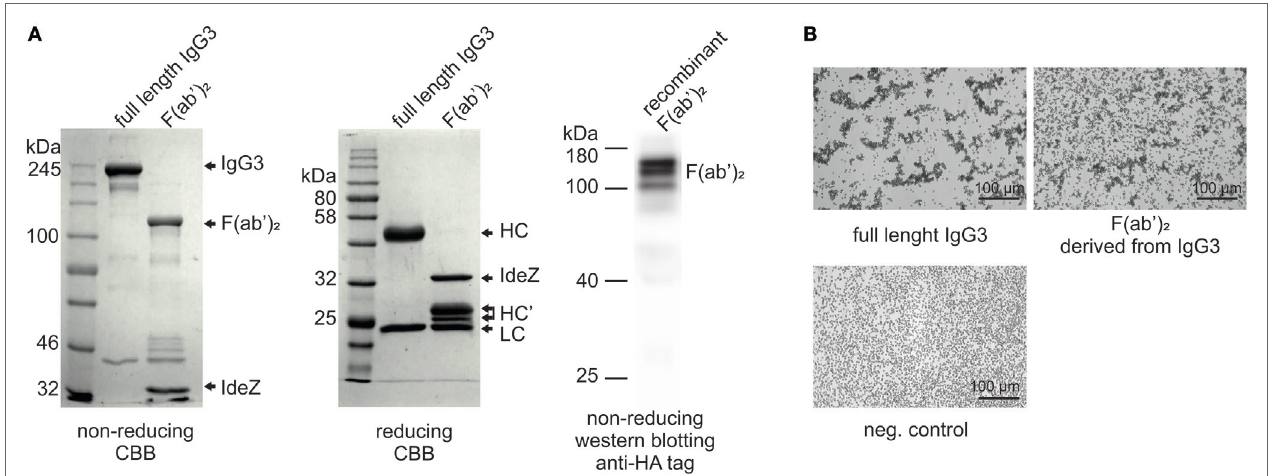
FigUre 1 | Hemagglutination induced by M18 IgG3 and its F(ab’) 2 . (a) Integrity of generated F(ab’) 2 was verified using SDS-PAGE. In the case of the purified antibody digested with IdeZ, the gels were stained with Coomassie Brilliant Blue (CBB). Recombinant F(ab’) 2 was equipped with HA tag and its integrity was confirmed using Western blotting with anti-HA tag antibody. The molecular mass of non-reduced F(ab’) 2 is about 120 kDa. HC, heavy chain; HC’, heavy chain fragments generated after IdeZ cleavage; LC, light chain; (B) Microscopic images of erythrocytes agglutinated by equal molar concentrations of IgG3 antibody and its F(ab’) 2 . The antibody fragment was obtained from native IgG3 using IdeZ digestion.